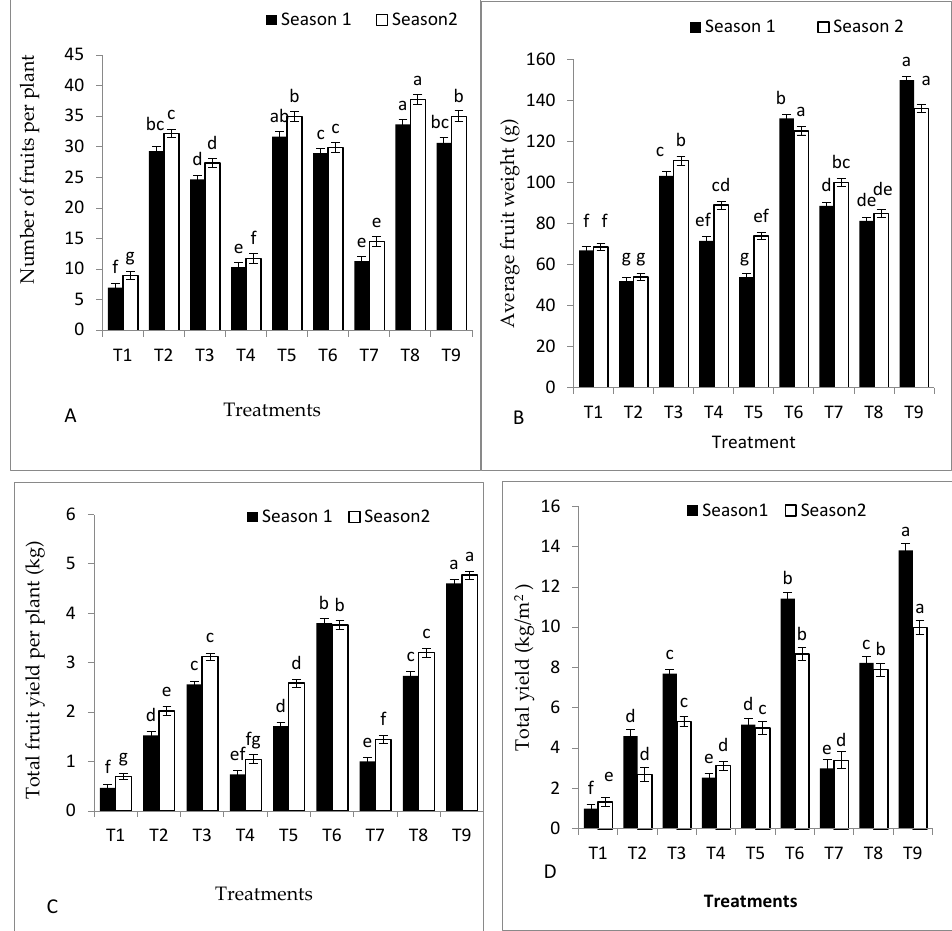
Figure 1. Effects of grafting, rootstock seed treated with SA, and colonisation with S. griseus on ( A ) average fruit weight, ( B ) number of fruits per plant, ( C ) total fruit yield per plant, and ( D ) total yield in the first and second seasons. Treatments: T1—self-grafted Peto 86/Peto 86 (control); T2—Peto 86/ S. cheesmaniae ; T3—Peto 86/GS hybrid; T4—Peto 86/Peto 86 + SA; T5—Peto 86/ S. cheesmaniae + SA; T6—Peto 86/GS hybrid + SA; T7—Peto 86/Peto 86 + S. griseus; T8 —Peto 86/ S. cheesmaniae + S . griseus; and T9—Peto 86/GS hybrid + S. griseus. Standard errors of the mean are shown as vertical bars; the LSD test indicates that differences between values in each bar that are marked by different letters are significant at p = 0.05.